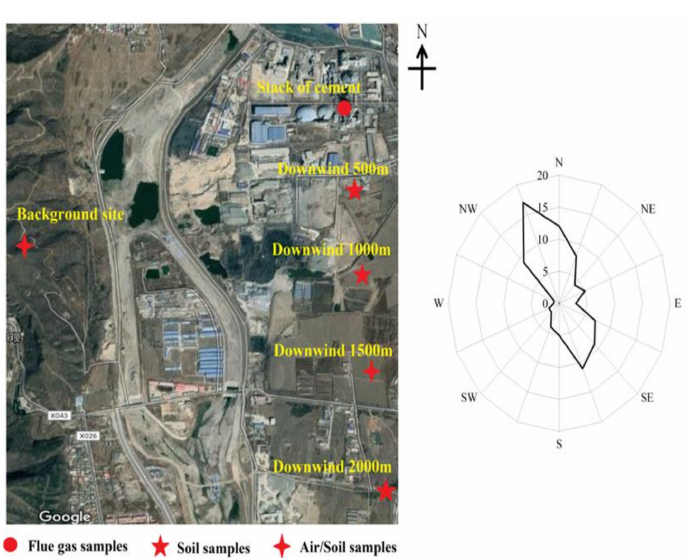
Figure 1. Sampling sites for flue gas and air/soil